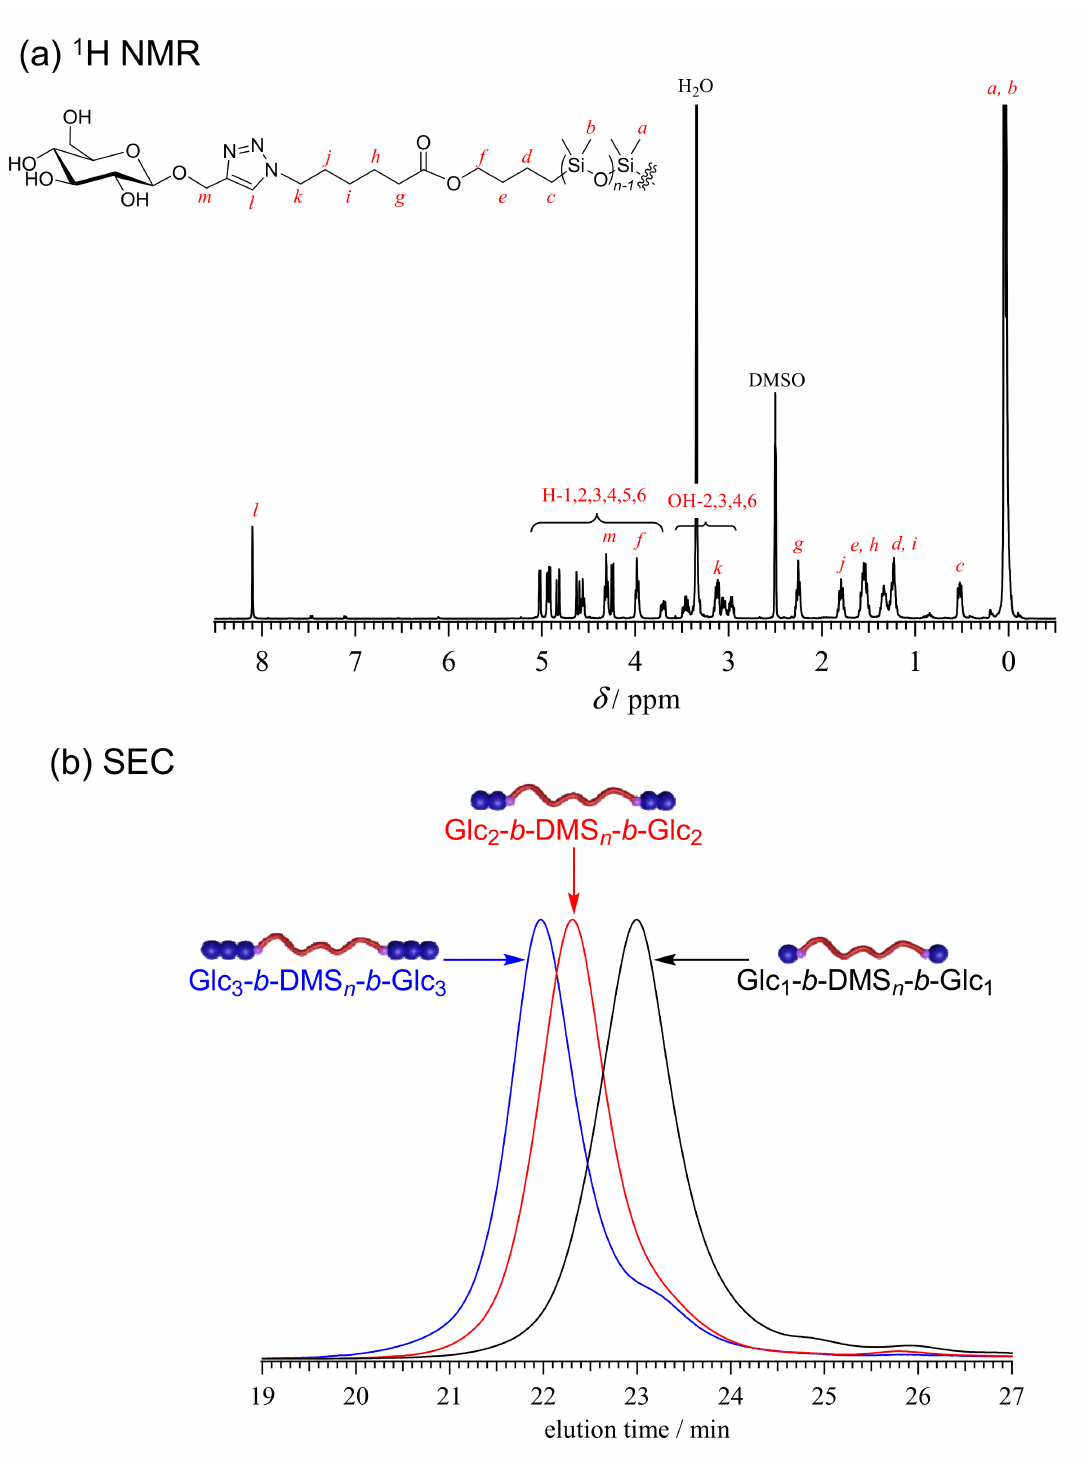
Figure 1. ( a ) 1 H NMR spectrum of Glc 1 - b -DMS n - b -Glc 1 in DMSO- d 6 (400 MHz); ( b ) SEC traces of Glc 1 - b -DMS n - b -Glc 1 (black), Glc 2 - b -DMS n - b -Glc 2 (red) and Glc 3 - b -DMS n - b -Glc 3 (blue) (eluent, DMF containing 0.01 mol L − 1 LiCl; flow rate, 0.60 mL min − 1